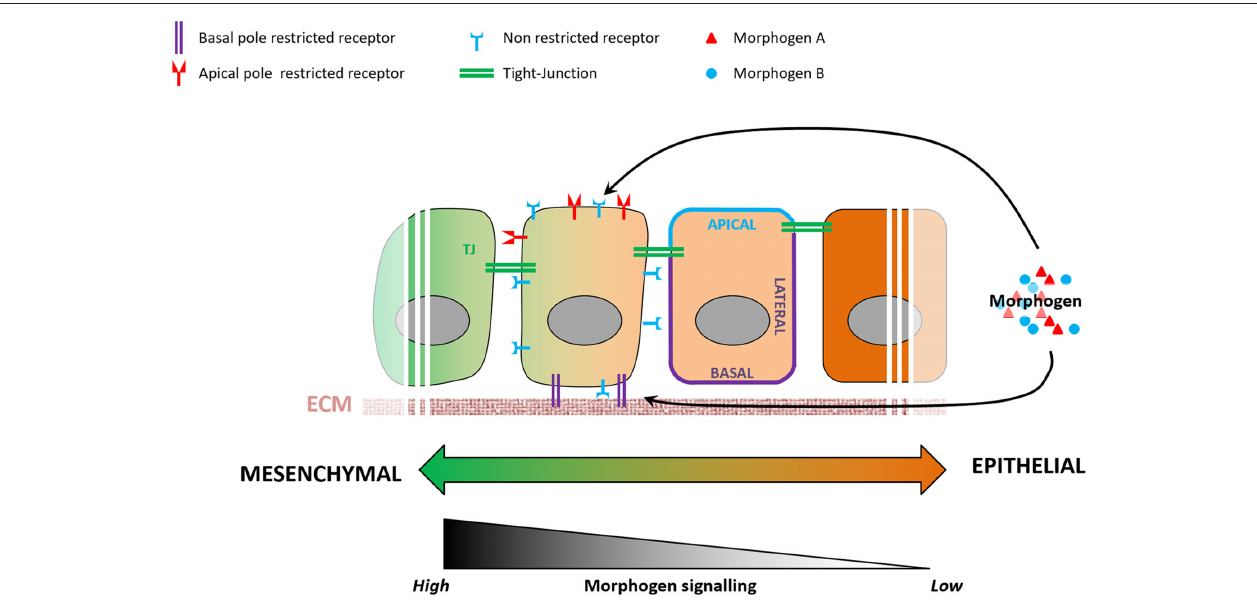
FIGURE 3 | Variations in epithelial organization can modulate levels of cellular response to a given morphogen. During the epithelialization process, tight junctions act as impermeable seals that compartmentalize the apical and basolateral membranes of a cell. As a consequence, a morphogen present at the apical pole will not be able to reach receptors localized on the basolateral membrane, and vice-versa. Some receptors are known to be localized specifically to either the apical or basolateral plasma membranes, and variations in cell’s epithelial organization will result in different levels of signaling pathway activation.